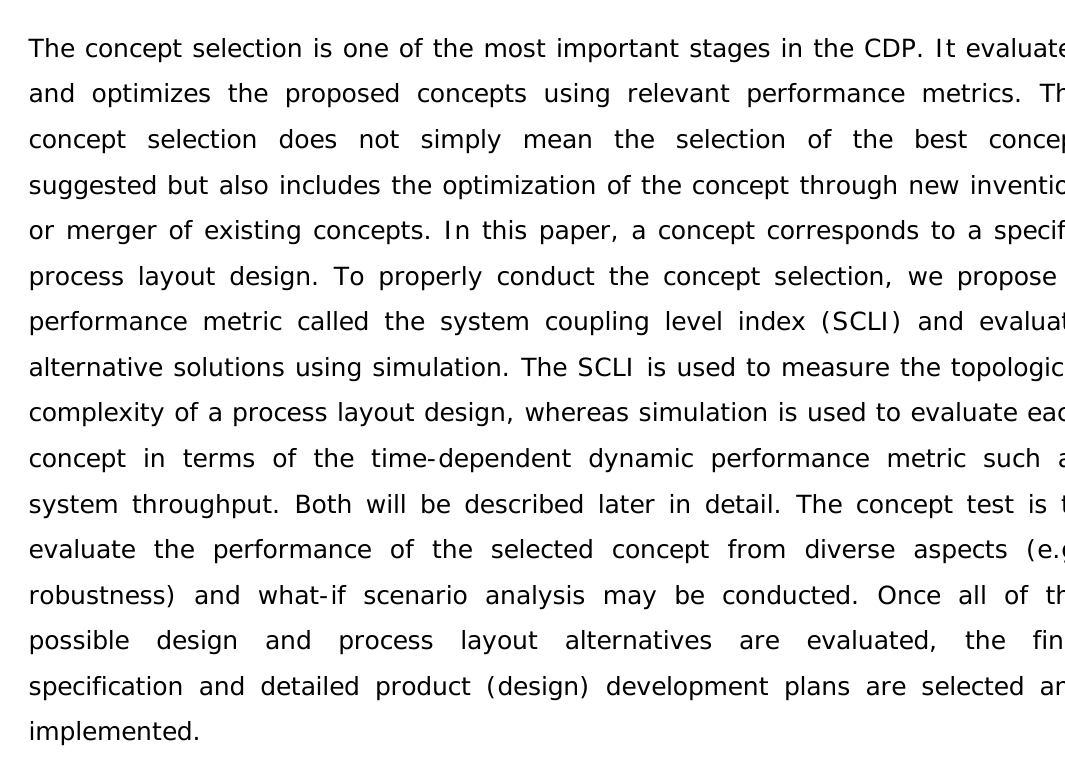
Figure 1. “Overall concept development process”. Source: Ulrich and Eppinger